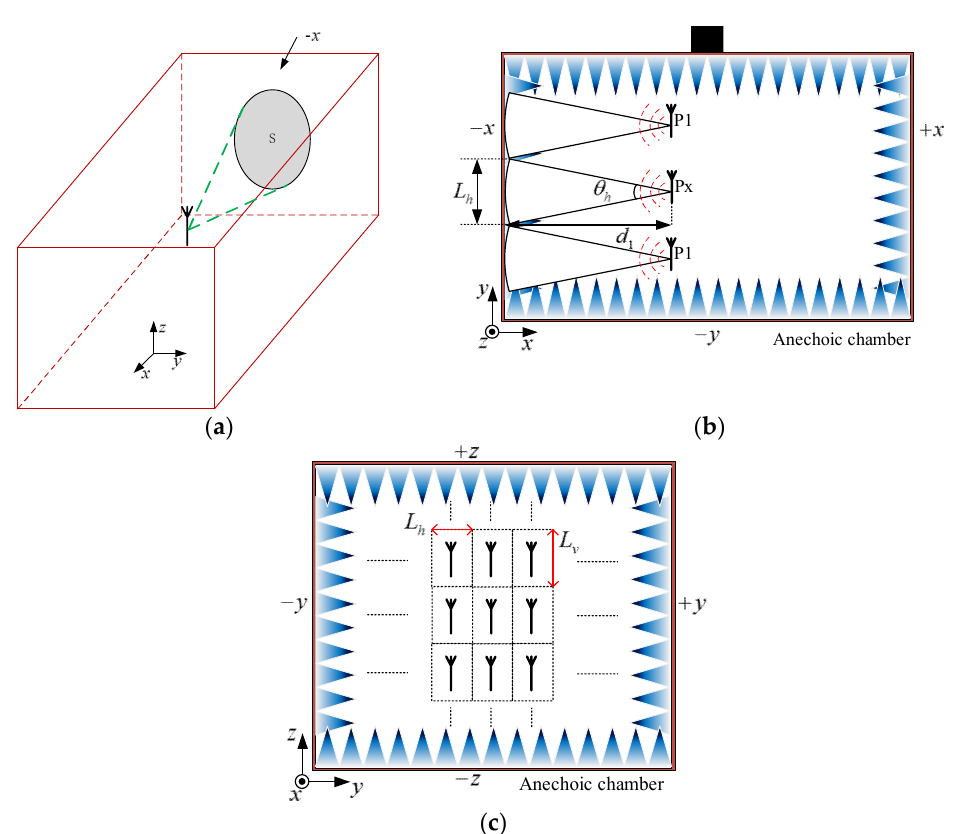
Figure 5. Selection method of measurement positions for the − x plane. ( a ) Main lobe projection of the antenna. ( b ) Sectional view of the xoy plane, and ( c ) sectional view of the yoz